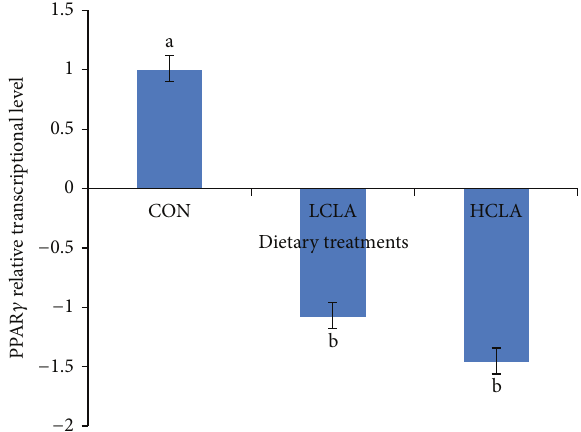
Figure 2: Comparison of PPAR 𝛾 relative transcriptional level in the abdominal fat of chickens fed diets with CON, LCLA, and HCLA. Values were normalized with reference genes, 𝛽 -actin, and GAPDH. Then, treated samples were expressed relative to transcriptional level of CON group. Values are mean ±1 standard error ( 𝑛 = 10 ). CON: without CLA; LCLA: low CLA; HCLA: high CLA. Letter in superscript indicated a significant difference compared with the CON group ( 𝑃 < 0.05 ).